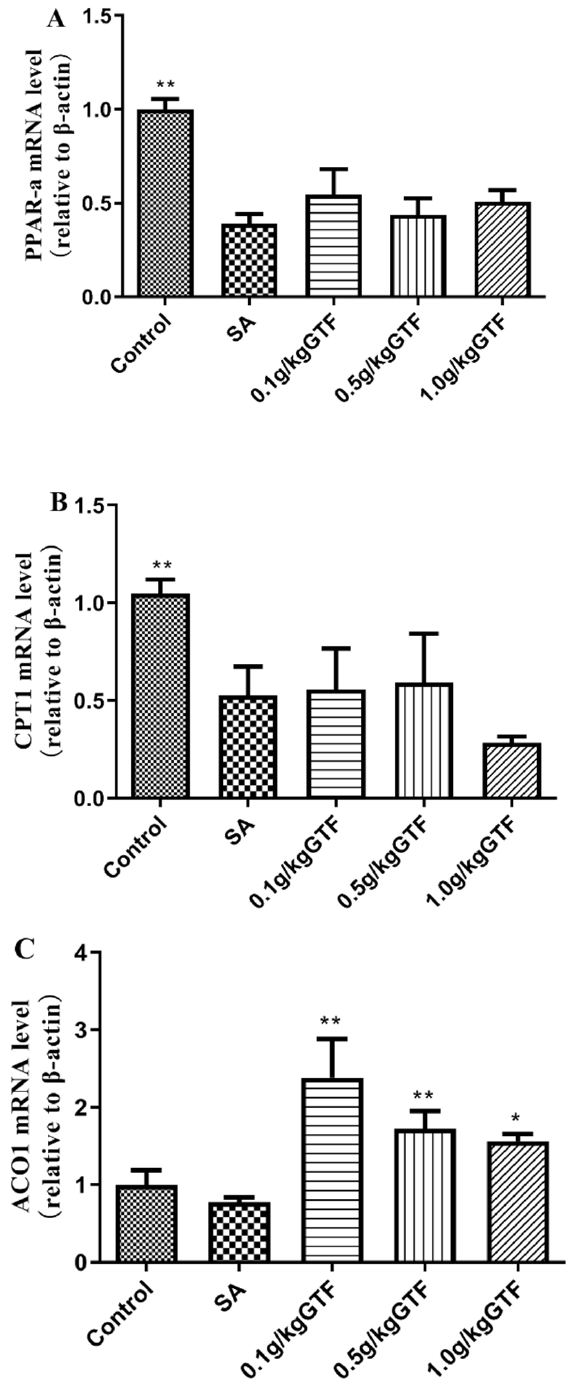
Figure 5. Effects of GTF on the mRNA levels of PPARa ( A ), CPT1 ( B ) and ACO1 ( C ) in the liver of tilapia. Values are expressed as mean ± SEM ( n = 10). * p < 0.05 and ** p < 0.01 compared with streptococcal injection group.